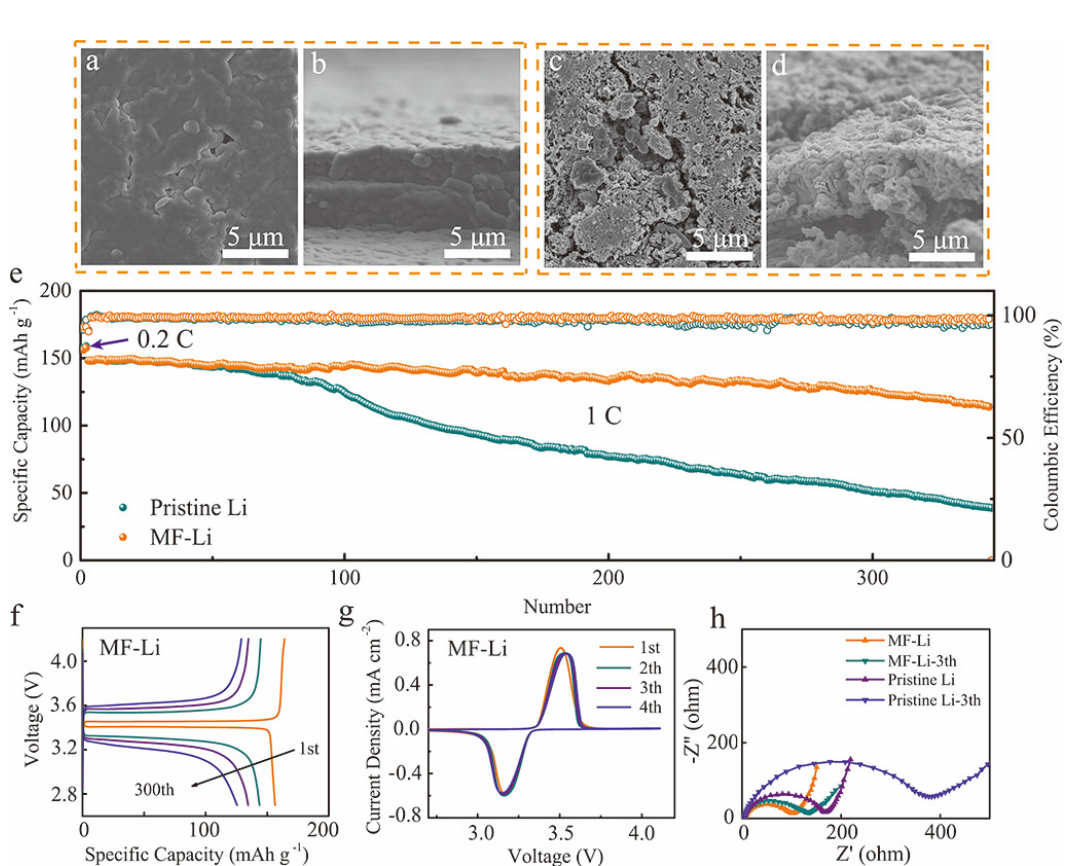
Figure 5. Cycling performance of the MF-Li||LFP cell and the Li||LFP cell at the rate of 1 C. Top view and the cross-section SEM images of ( a , b ) the MF-Li anode and ( c , d ) the pristine Li anode after 30 cycles. ( e ) Cycling stabilities of full cells with the MF-Li and pristine Li anodes. ( f ) The charge/discharge profiles at different cycles of the MF-Li||LFP cell. ( g ) CV curves of the MF-Li||LFP cell at the scan rate 0.1 mV s − 1 . ( h ) EIS spectra of the Li||LFP cells with different anodes at the original state and after three